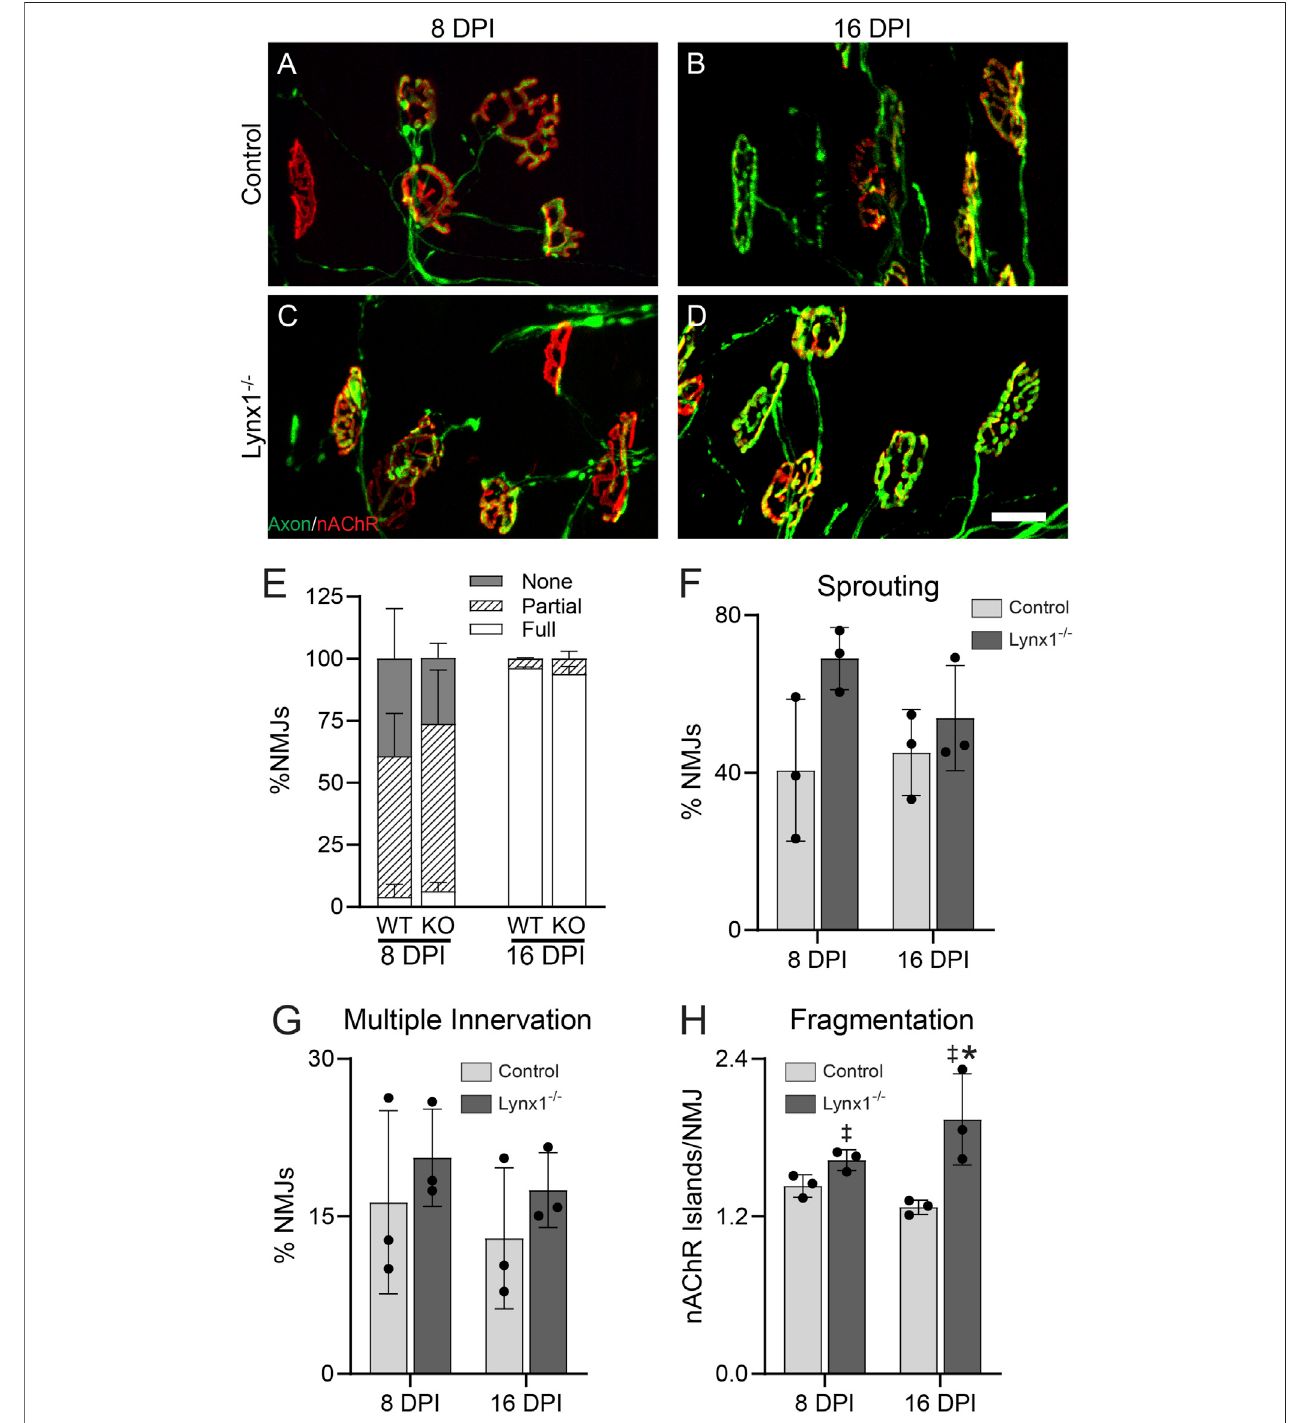
FIGURE8| LossofLynx1doesnotaffect thestability norrepair ofneuromuscular junctions(NMJs)followingdenervation. (A,B) Representativeimages ofNMJs in the extensor digitorum longus (EDL) at 8 (A,C) and 16 days post-nerve crush injury (DPI). Motor axons were labeled with YFP (green), and nicotinic acetylcholine receptors (nAChRs) were labeled with fl uorescently conjugated α -bungarotoxin (fBTX, red). (E) The percentage of innervated NMJs, either fully, partially, or not at all. (F – H) MorphologicalanalysisofNMJs, including (F) thepresenceofaxonsprouts, (G) multipleinnervations,and (H) nAChR fragmentation.* p < 0.05versusinjury- matched control; ‡ genotype effect, p < 0.05; two-way ANOVA with Š ídák ’ s multiple comparisons test. n = 3. All values are mean ± SD. Scale bar = 25 µm.